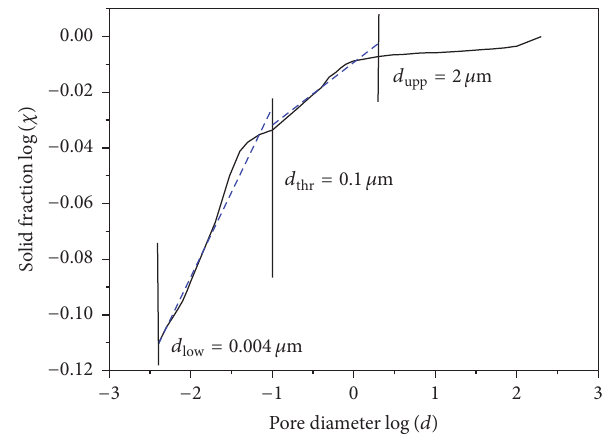
Figure 2: Porosimetric data example: cumulative intrusion volume against pore diameter.